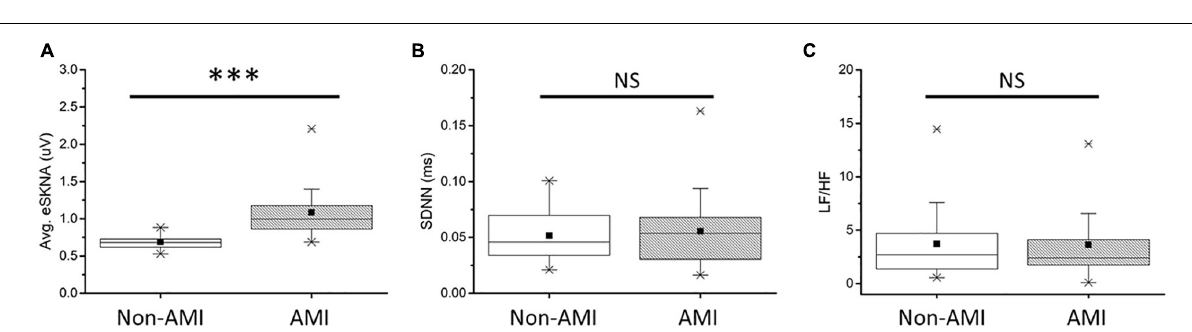
FIGURE 4 | (A) The correlation between average eSKNA and HRV parameters in non-AMI groups. (B) The correlation between average eSKNA and HRV parameters in AMI groups. ∗∗ Statistically significant ( p < 0.01).